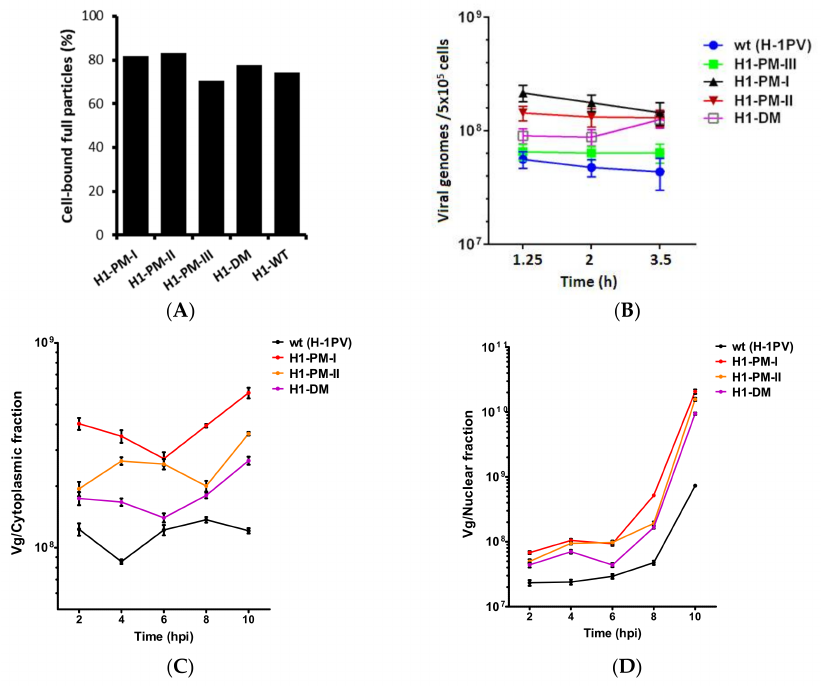
Figure 8. Comparison of cell binding ( A ), uptake ( B ); and nuclear import ( C , D ) of wt H-1PV particles and of H1-derived mutants. ( A ) NB-324K cells (5 × 10 5 ) were infected with wt (H-1PV) or H1-PM-III, H1-PM-I, H1-PM-II, and H1-DM mutants at MOI of 2225 Vg/cell at 4 ◦ C for 1 h. The amount of cell-bound full particles was quantified by qPCR and expressed as the percentage of total (cell-bound and supernatant) viral genome; ( B ) NB-324k cells (5 × 10 5 ) were infected at 4 ◦ C for 1 h with wt H-1PV or the mutants and further incubated at 37 ◦ C. Cells were harvested at the indicated times of infection and treated with trypsin-EDTA. Viral genomes recovered from cell lysates were quantified by qPCR and given in Vg ( C , D ). Kinetics of cytoplasmic/nuclear distribution of wt and mutant viruses. NB-324K cells (5 × 10 5 ) were infected and further incubated as for ( B ). At indicated times of infection, viral particles were isolated from cytoplasmic ( C ) and nuclear ( D ) fractions and the amount of viral genome determined by qPCR. Mean ± SD of two independent